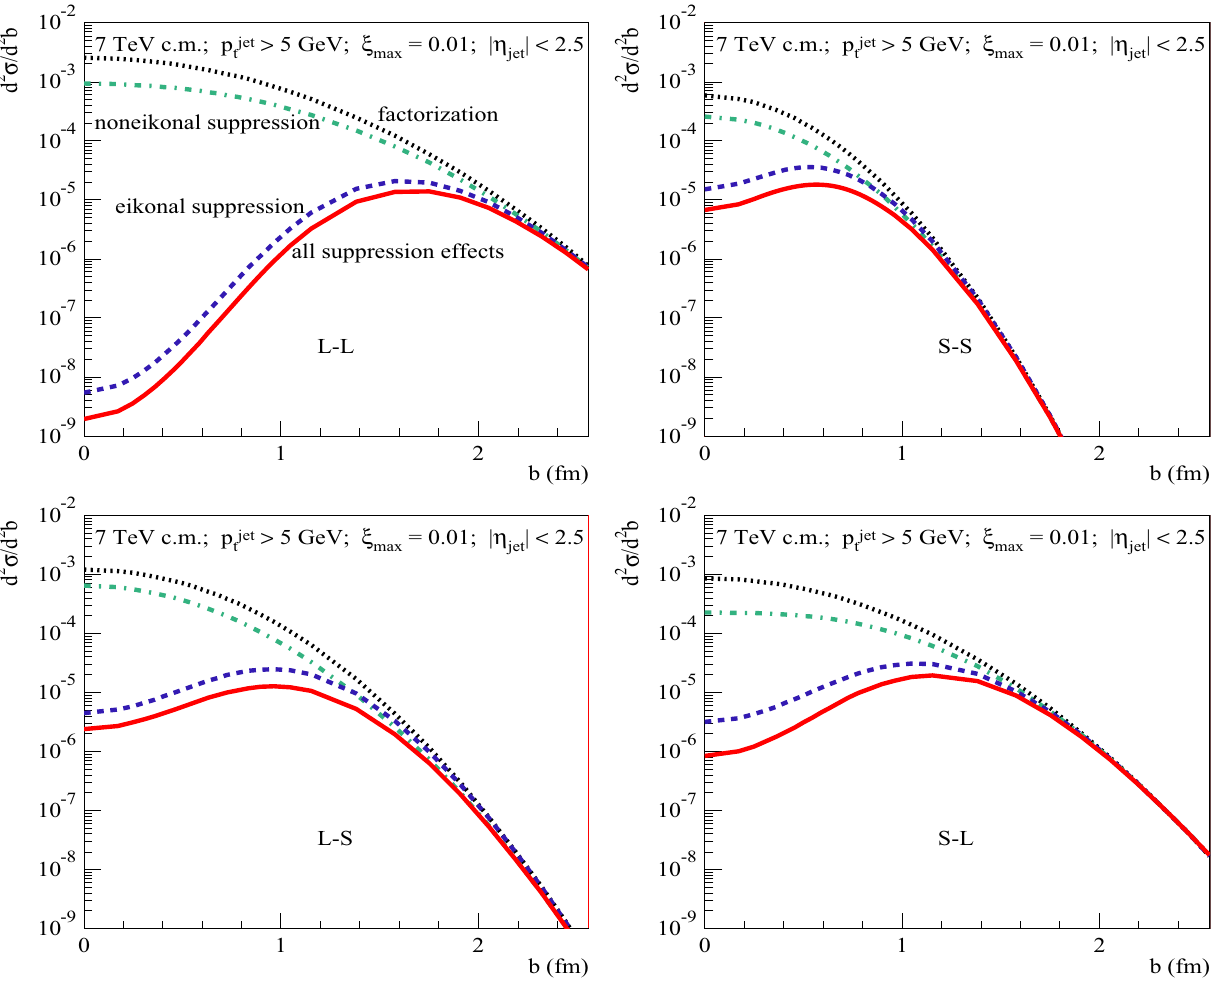
Fig. 13 Same as in Fig. 11 (right) for different combinations of diffractive eigenstates of the projectile and target protons, as explained in the text